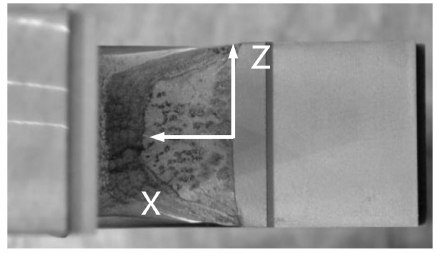
Figure 8. Appearance of fracture in a 3PB CTOD test specimen (33 mm thickness).